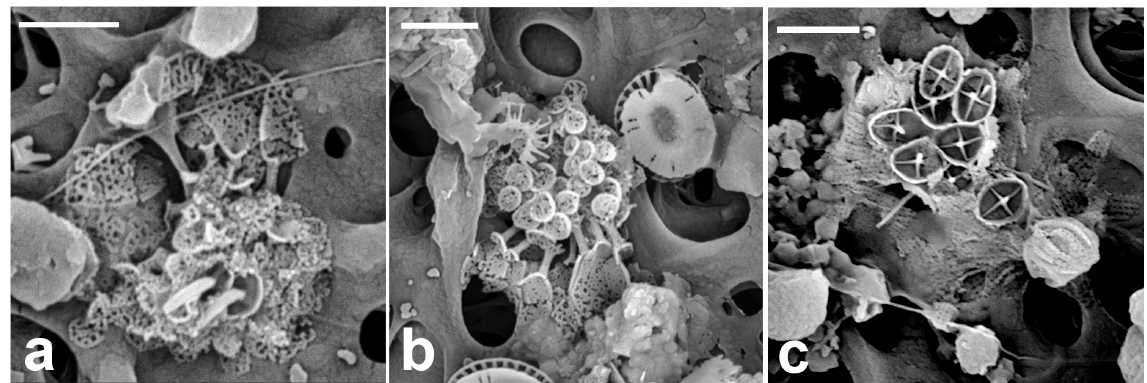
Figure 14. (a) Combination cell of Picarola margalefii . (b) Papposphaera polybotrys- like HOL. (c) Combination cell of Papposphaera sp. ( a : GoA, 18 April 2017, 120m and b, c : 140m). Scale bars: